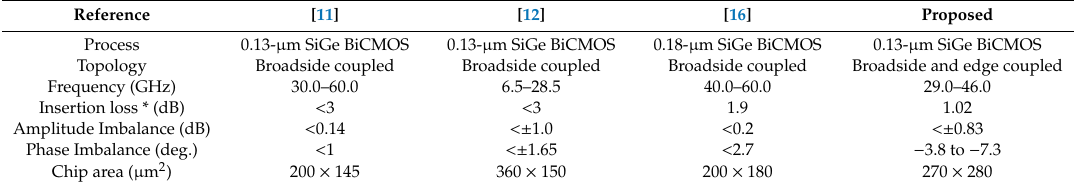
Table 2. Performance comparison with reported